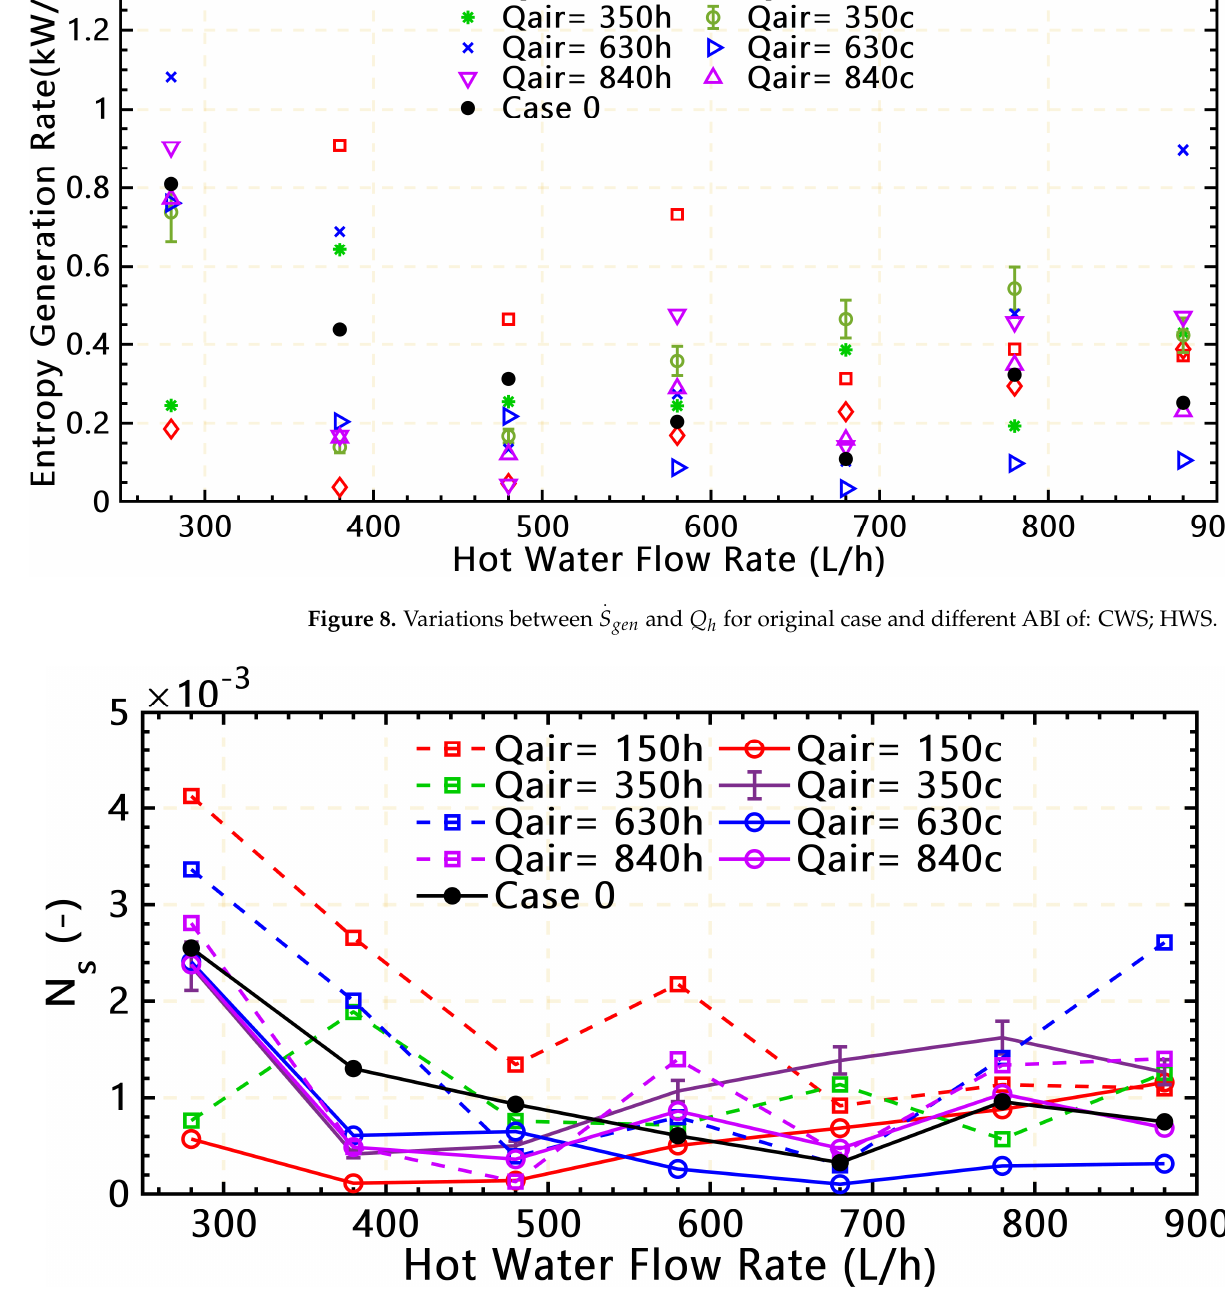
Figure 9. Relationship between 𝑁 (cid:3046) and 𝑄 (cid:3035) at different operating conditions without/with ABI.